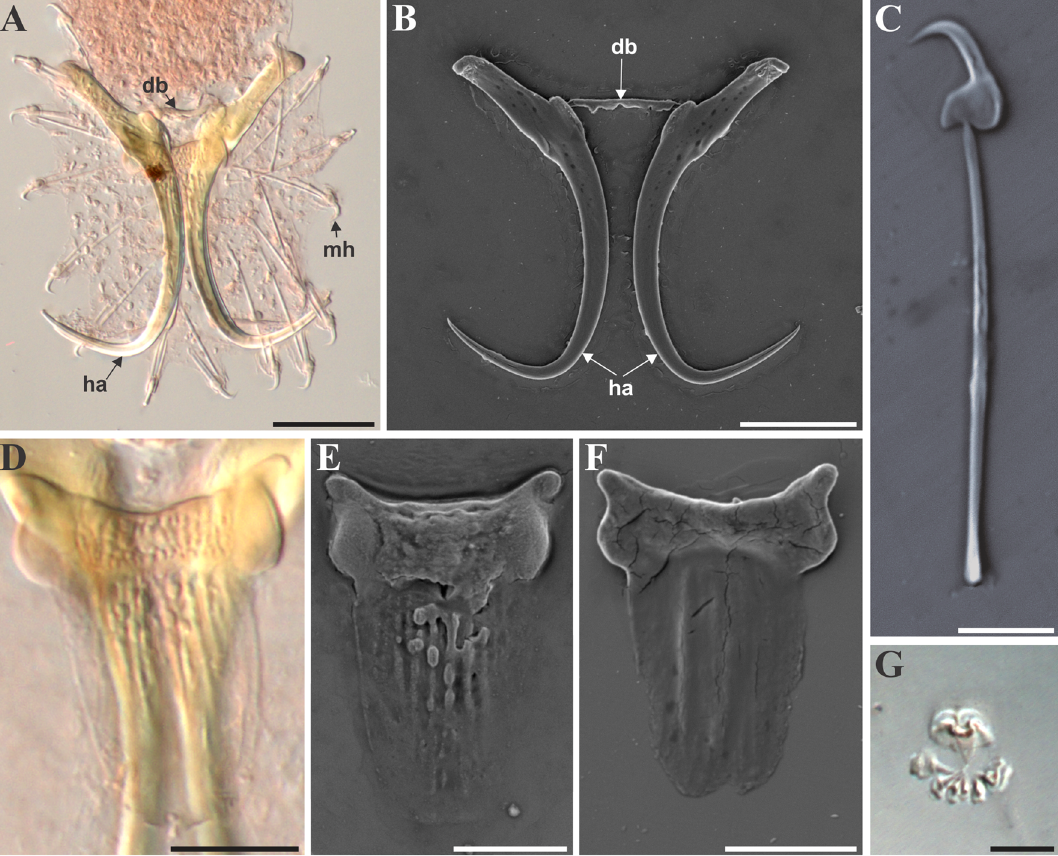
Figure 3. Light (LM) and scanning electron (SEM) micrographs of the haptoral sclerites and male copulatory organ (MCO) of Gyrodactylus magadiensis n. sp. (A) Haptoral sclerites with hamulus (ha), dorsal bar (db), and marginal hooks (mh), GAP (LM); (B) hamulus (ha) and dorsal bar (db) after soft tissue digestion (SEM); (C) isolated marginal hook (SEM); (D) dorsal bar (LM); (E) dorsal view of dorsal bar (SEM); (F) ventral view of dorsal bar (SEM); (G) male copulatory organ (MCO) with large central spine and six spinelets, two large and four small (LM). Scale bars – (A and B) 20 l m; (C and G) 5 l m; (D – F) 10 l